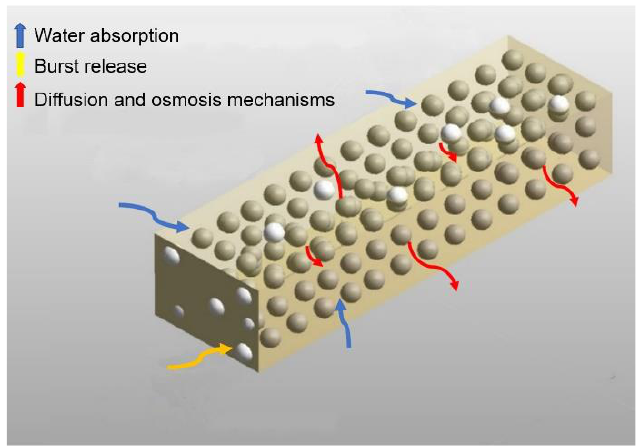
Figure 3. Schematic of the phenomena occurring during the release. Yellow rectangle is the polymer matrix, white spheres are the drug particles on the surface contacting with outside, golden spheres are drug particles inside the polymeric matrix. The arrows show the phenomena of water absorption, burst release and mechanisms of diffusion and osmosis.